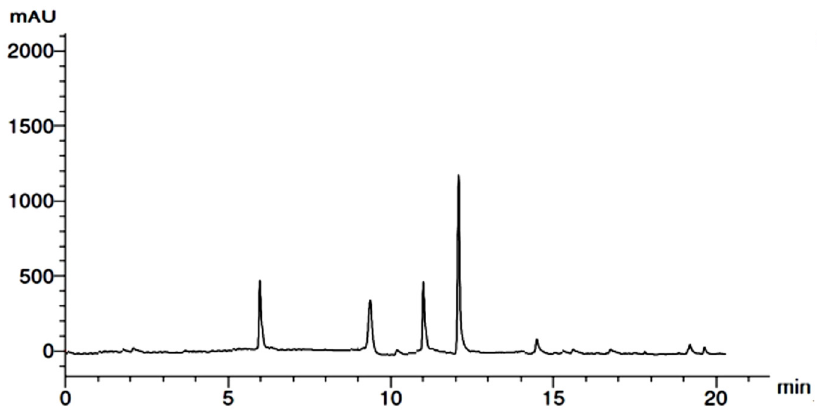
Table 2. HPLC flavonoids data of G. biloba leaves.